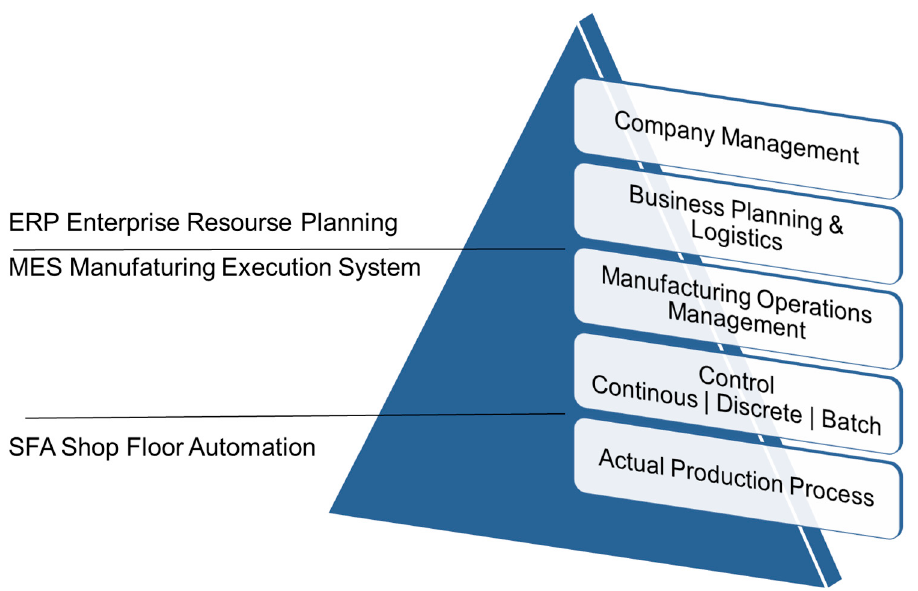
Figure 20. Functional hierarchy according to ISA95 (own elaboration).